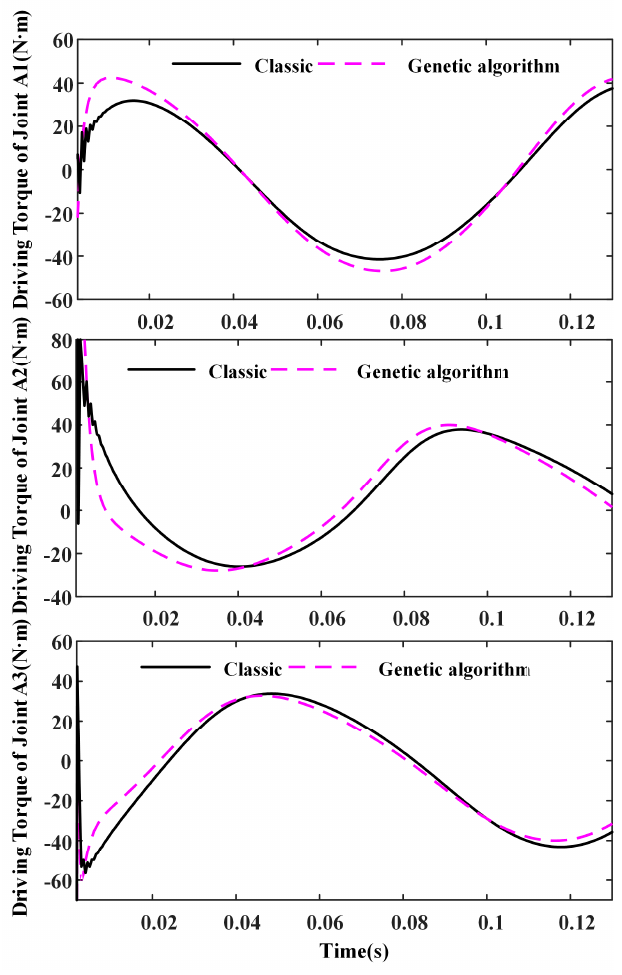
Figure 12. The torque curves produced by the classic PID control and the GA–PID control.